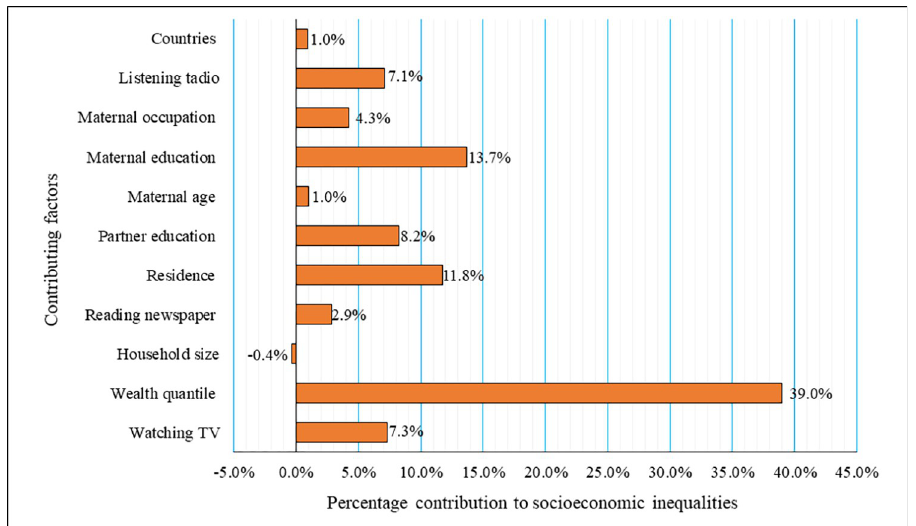
Fig 2. Contribution of various factors to prenatal HIV test service uptake for PMTCT in East Africa.